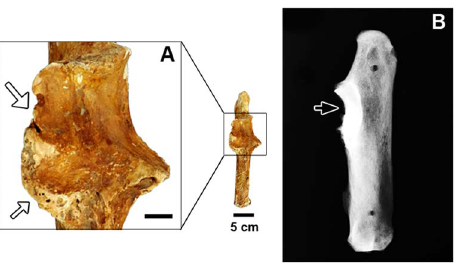
Figure 2. Right ulna of Glyptotherium (MCC 491-V). (A) A detail of the trochlear and radial notch in a cranial view; (B) Lateral radiography. The large white arrow indicate bone erosion, the smaller white arrow indicates bone growth and the black arrow indicates sclerosis. Scale bar in the detail A=1 cm.